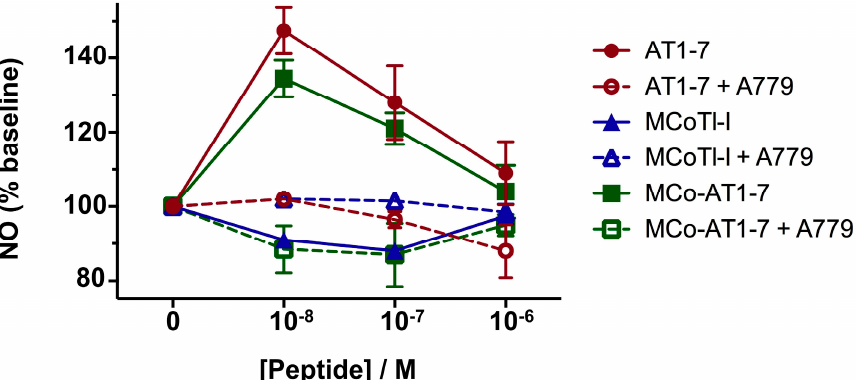
Figure 5. Biological activity of cyclotide MCo-AT1-7. MAS1 stably transfected CHO cells were tested using different concentrations of cyclotide MCo-AT1-7 and peptide AT1-7 in the absence or presence of MAS1 antagonist A779. The amount of intracellular NO was measured by fluorescence as described in the experimental section. Cyclotide MCoTI-I was used as negative control. The average of standard deviation of two experiments is shown.